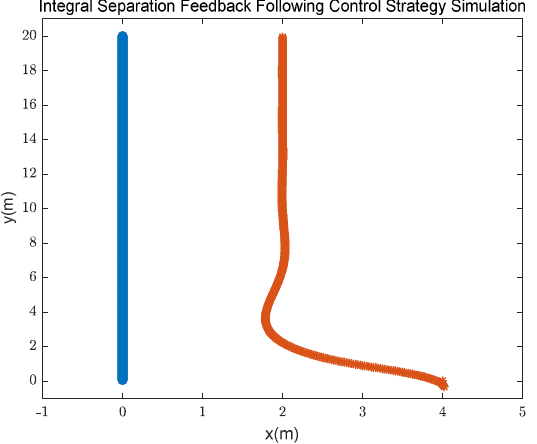
Figure 10. Formation distance and bearing angle variation of the optimized model (desired follow- ing position set at (2, 0  ) ).